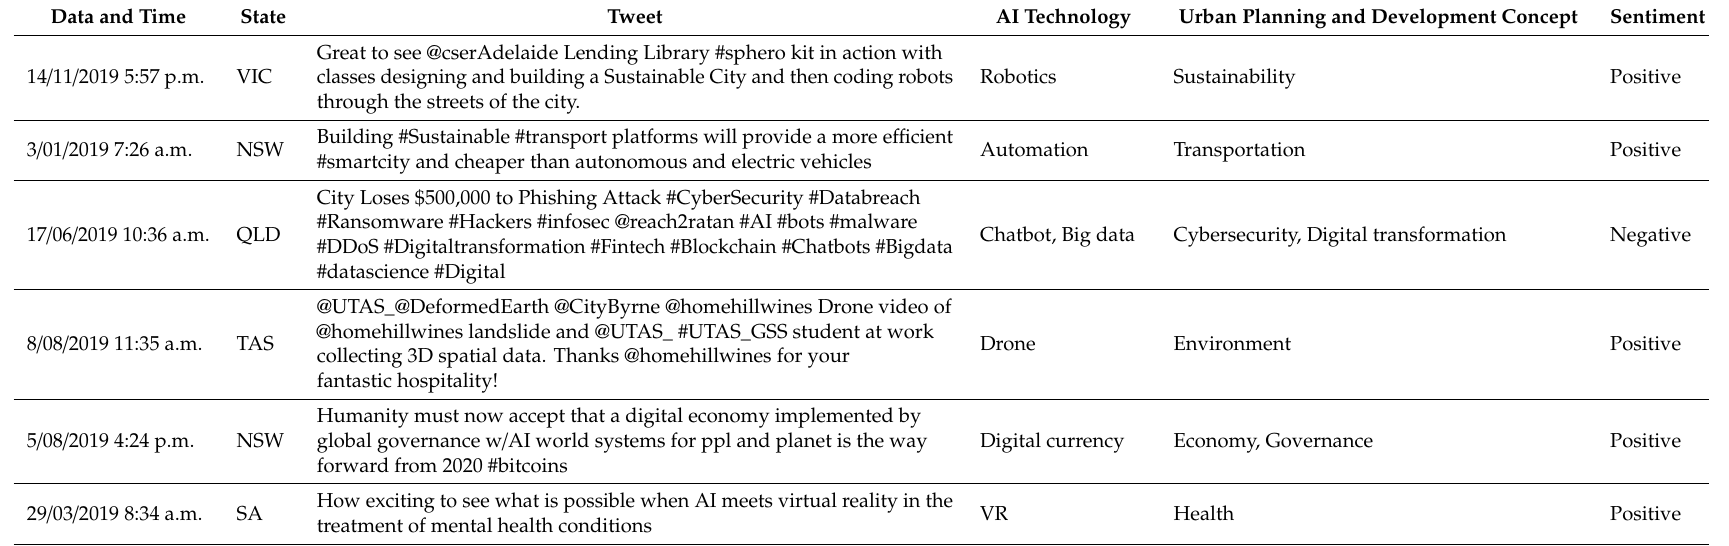
Table 8. Example tweets showing the relationship between AI technologies and urban planning and development